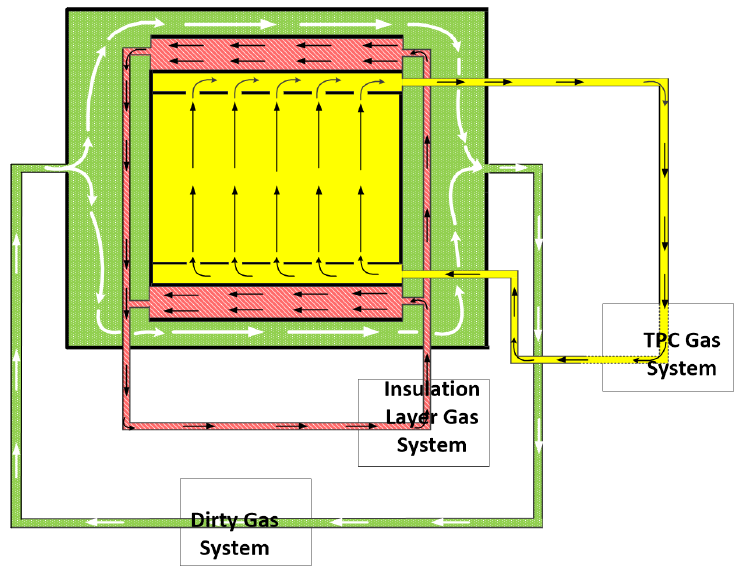
Figure 2. Gas systems for the ND-GAr pressure vessel for a dual-anode TPC.